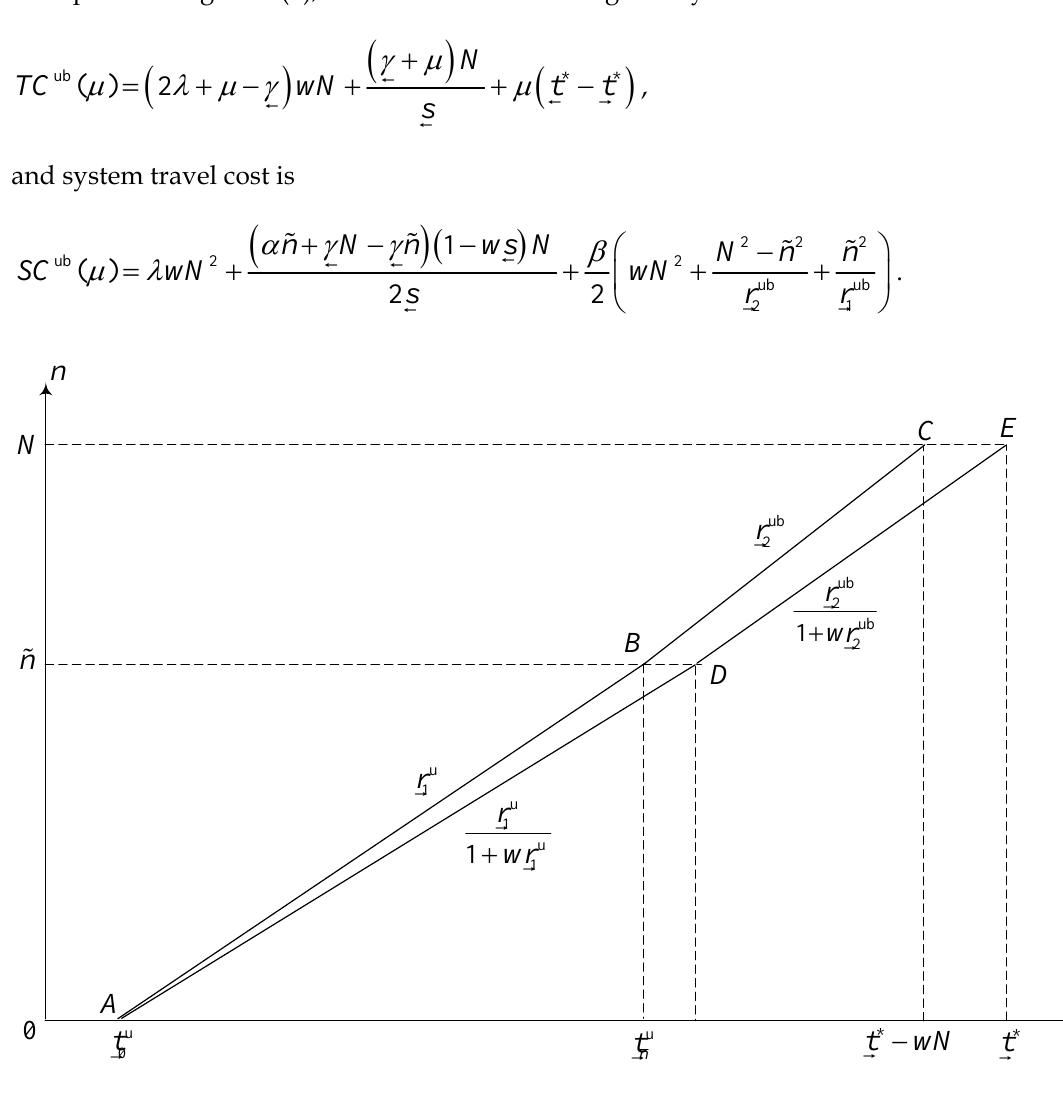
Figure 4. User equilibrium traffic pattern in the morning commute, regime u(b)